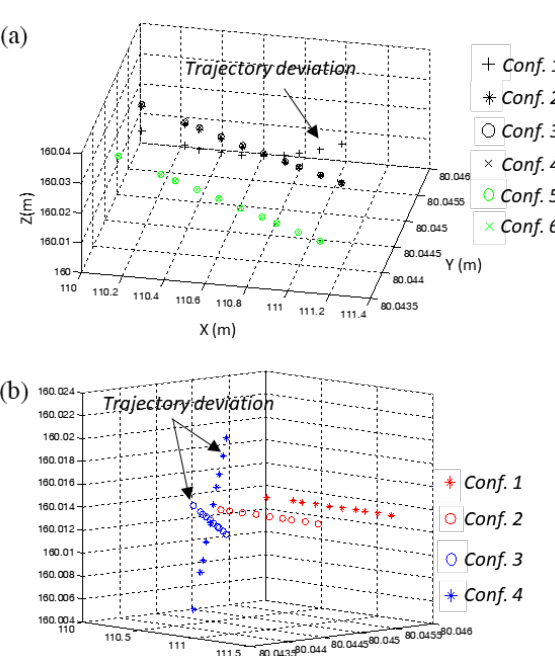
Figure 4. Interpolation of ten band positions using 4-band BAPM in a cube considering the configurations (Conf..)